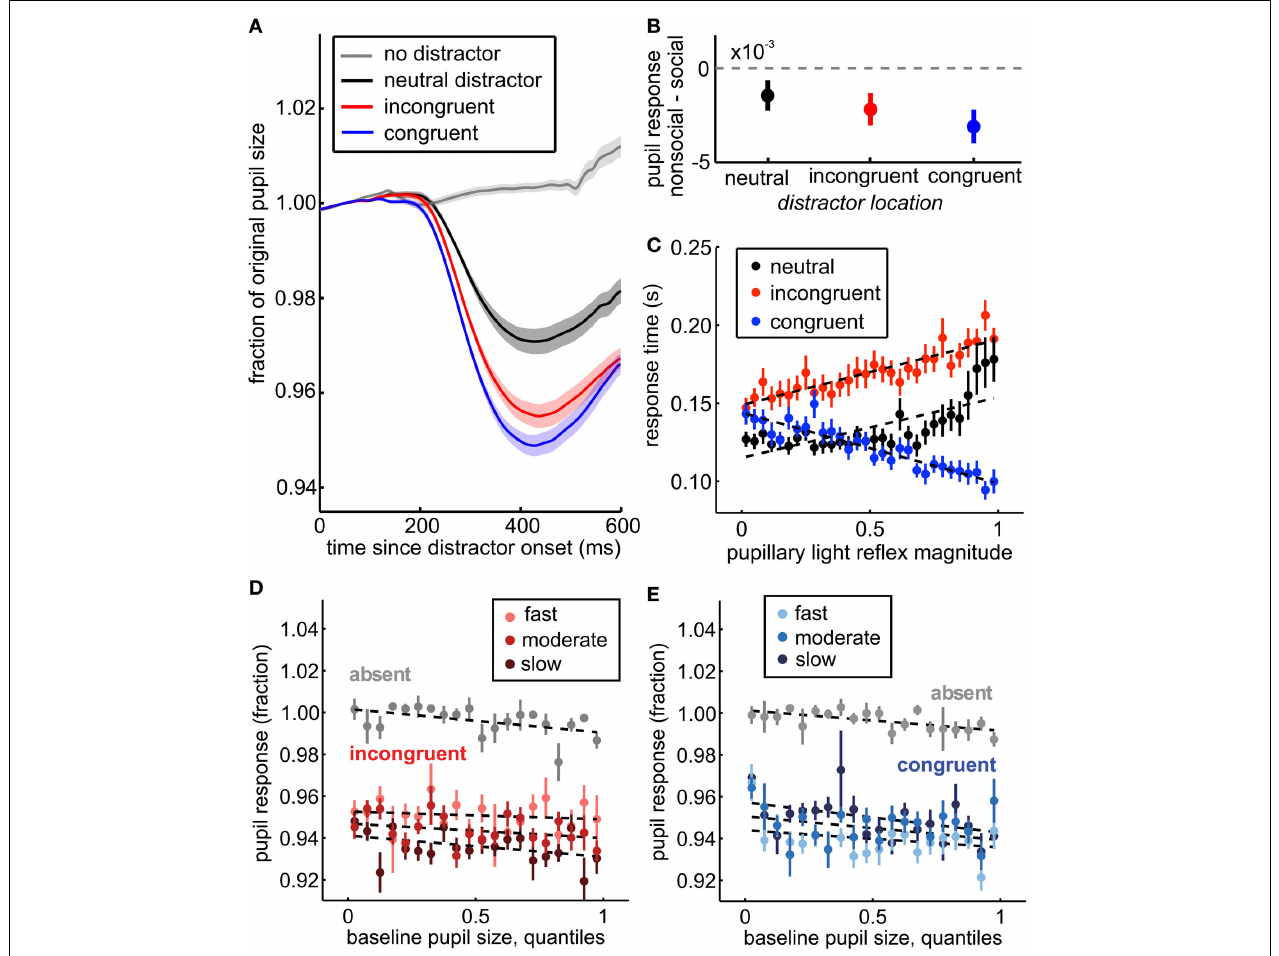
FIGURE 3 | The pupil light response indexes spatial attention, social relevance, and trial-by-trial variation in distractor response time effects. (A) Pupil traces, averaged across sessions, aligned to distractor onset (black, red, and blue traces) or to sham distractor time stamps (gray). The pupil response was enhanced for distractors in congruent (blue) and incongruent (red) locations compared to distractors that did not bias response time (neutral distractors, black). No pupil response was observed in the absence of distractors (gray). Shading ± s.e.m. across sessions. (B) Greater pupil constrictionwasobservedforsocialimagesthannon-socialimages,regardless of whether they were spatially incongruent (red), congruent (blue), or neutral (black) with respect to the target. Bars ± s.e.m. across sessions. (C) Within distractor locations, the magnitude of pupil constriction after distractor onset predicted their response time effects. Larger pupil light responses predicted longer saccade reaction times on incongruent distractor trials (red) and shorter saccade reaction times on congruent distractor trials (blue). Neutral trials are plotted for comparison (black),but not included intheGLM. Dottedlinesreflect